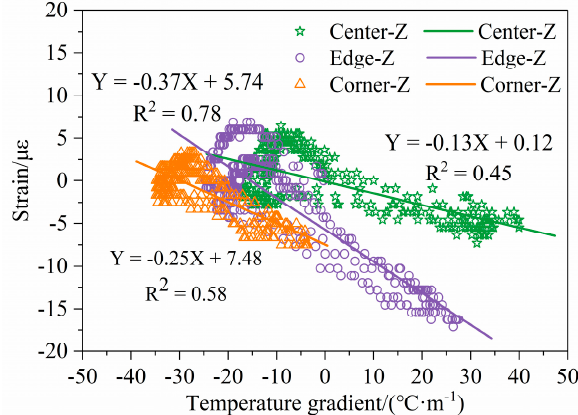
Figure 11. Relationship of temperature and vertical strain of